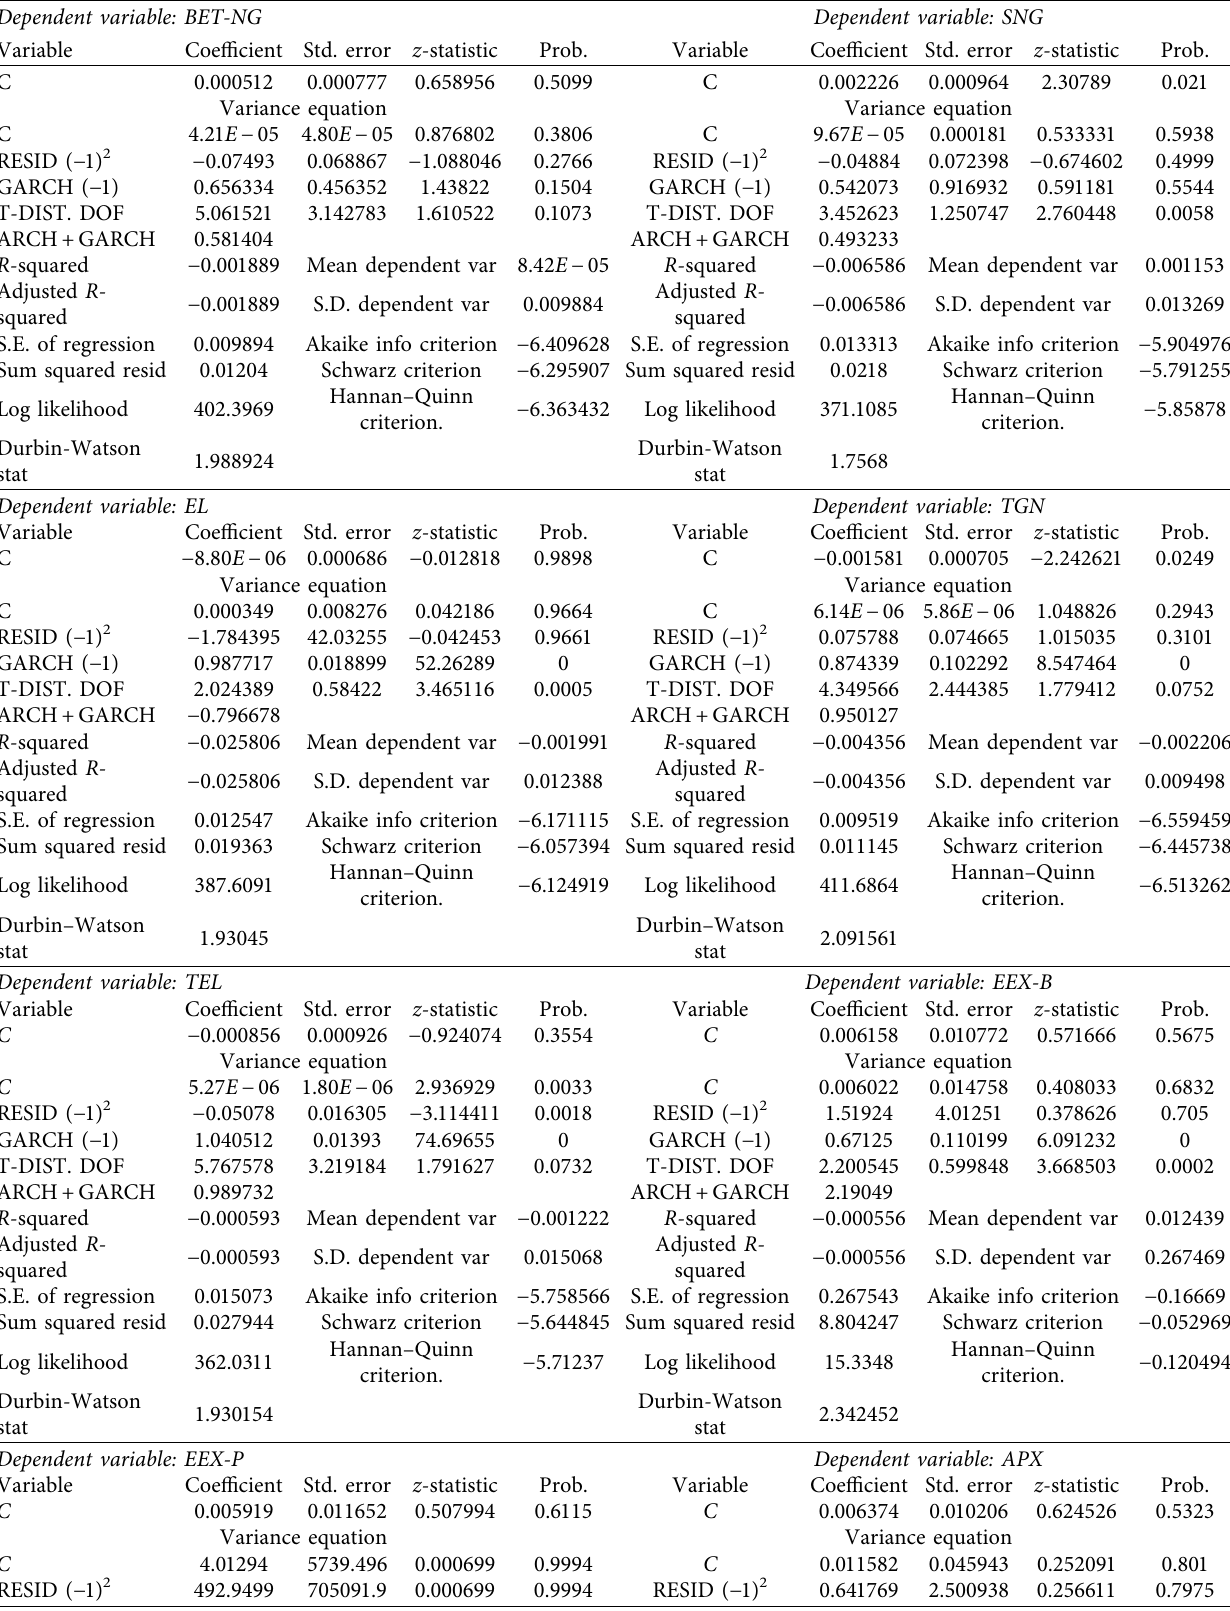
Table 7: The outcomes of the GARCH (1, 1)